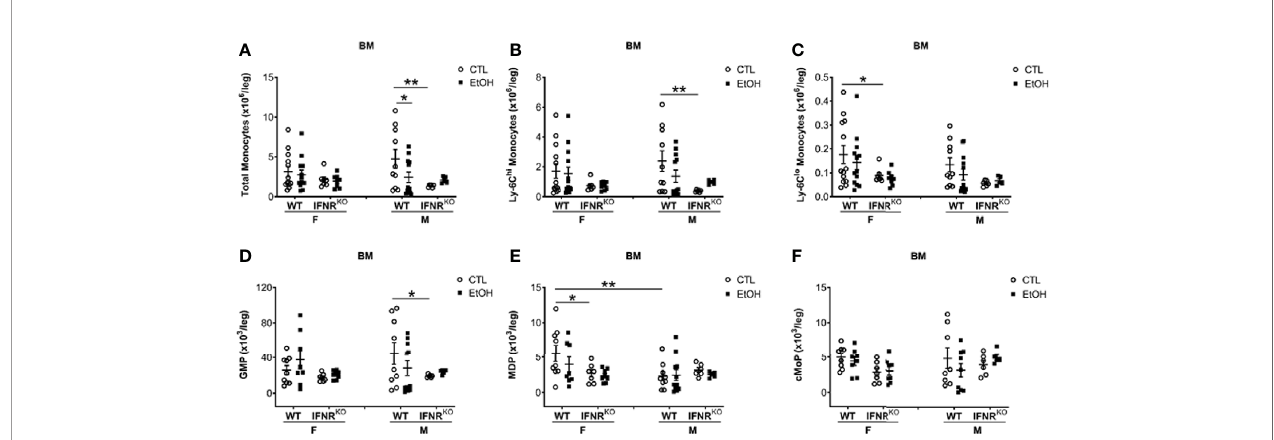
FIGURE 4 | Reduction in MDP, a monocyte BM progenitor, in female IFNR KO mice. Female (F) and male (M) from wild type (WT) and interferon a / b receptor knockout (IFNR KO ) mice were provided a regular chow diet and ethanol in drinking water (EtOH) or ethanol-free water (CTL). After 4 weeks, mice were euthanized, and BM collected, cells counted, then stained for fl ow cytometry analysis. (A – F) Dot graphs showing the numbers per leg of total monocytes (A) , Ly-6C hi monocytes (B) , Ly-6C lo monocytes (C) , GMP (D) , MDP (E) , and cMoP (F) . n ≥ 5. Values showing the mean ± SEM, *p<0.05,